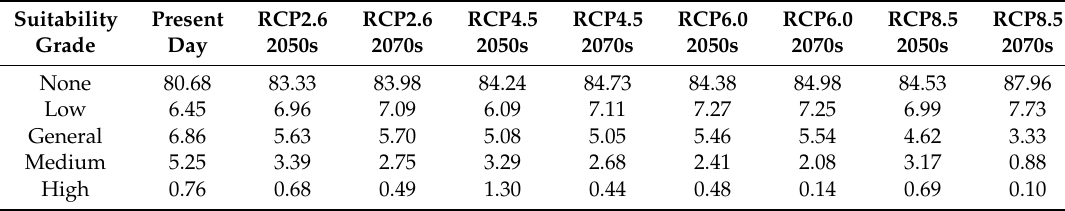
Table 4. Percentage of the predicted suitable area for the presence of Cunninghamia lanceolata for the present day, 2050s, and 2070s under different climate scenarios in China. RCPs: Representative Concentration Pathway data defined by the possible range of radiative forcing values (2.6, 4.5, 6.0, and 8.5 W/m 2 , respectively) in the year 2100 taken from the Beijing Climate Center Climate System Model